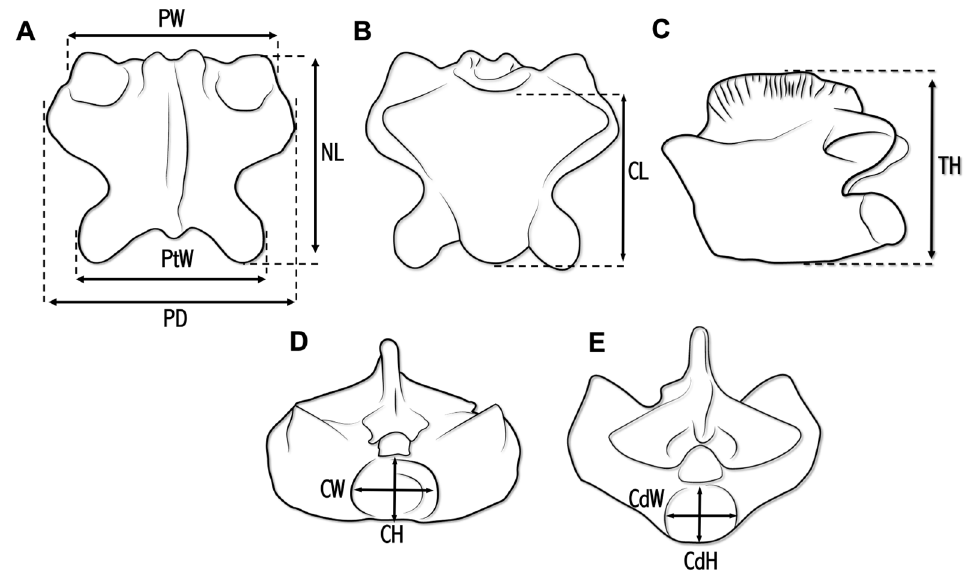
Figure 2. Schematic drawings showing the measurements taken on ALG 200, holotype of Carentonosaurus algorensis sp. nov., from the uppermost middle to lowermost upper Cenomanian site of Algora (Guadalajara Province, Central Spain). The vertebra is represented in dorsal ( A ), ventral ( B ), lateral ( C ), cranial ( D ), and caudal ( E ) views.